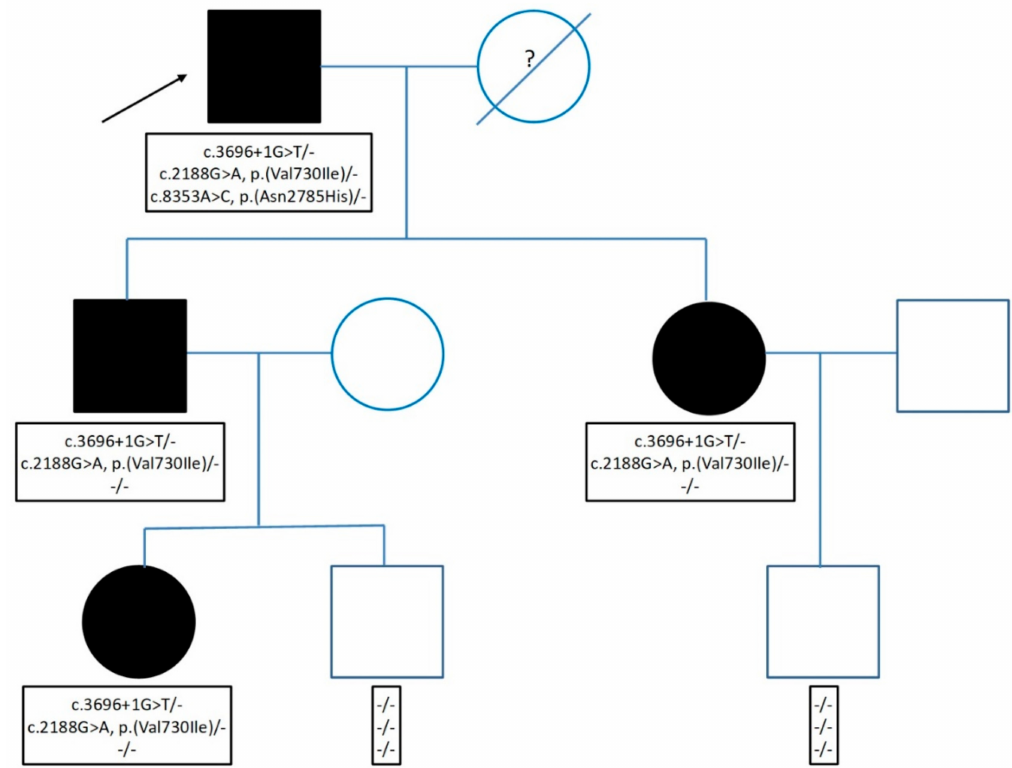
Figure 5. Family pedigree indicating the APOB variants identified for the proband and his family members. The proband is indicated with an arrow, circles correspond to female and squares to male family members. Filled symbols indicate a ff ected family members and empty symbols indicate healthy members. The question mark represents a lack of information (death before the